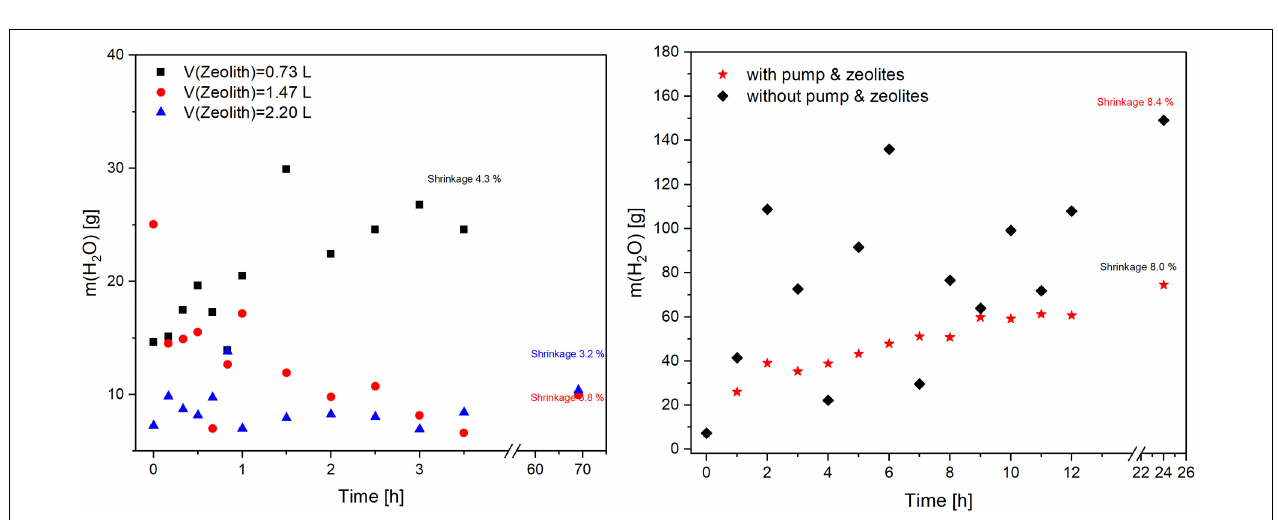
fluids. On their large surface area, water can be adsorbed. The adsorption capacity of the zeolites used in this study, was given by the manufacturer to be ≥ 20% at a relative humidity of 60% (FischerScientific, 2021). Prior to the use of zeolite, the maximum amount of possible adsorbed water was calculated. A completely filled perforated basket contained 2.20 L of